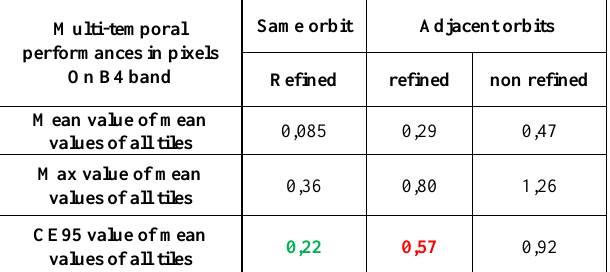
Table 6. Statistics on multi-temporal performances for L1C products: comparison for refined and non-refined products.